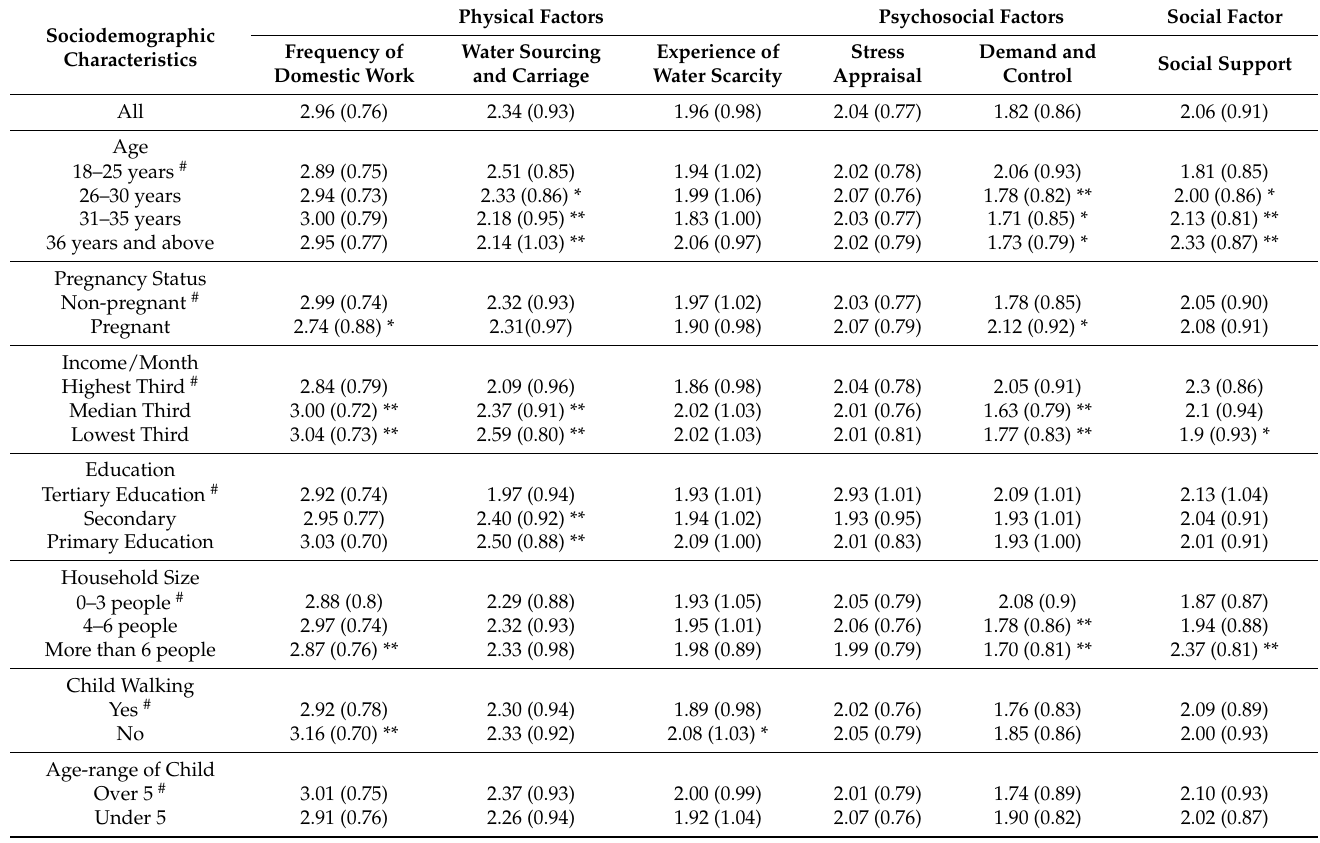
Table 3. Factor scores from domestic work experience measures across socio-demographic variables. Sociodemographic Characteristics